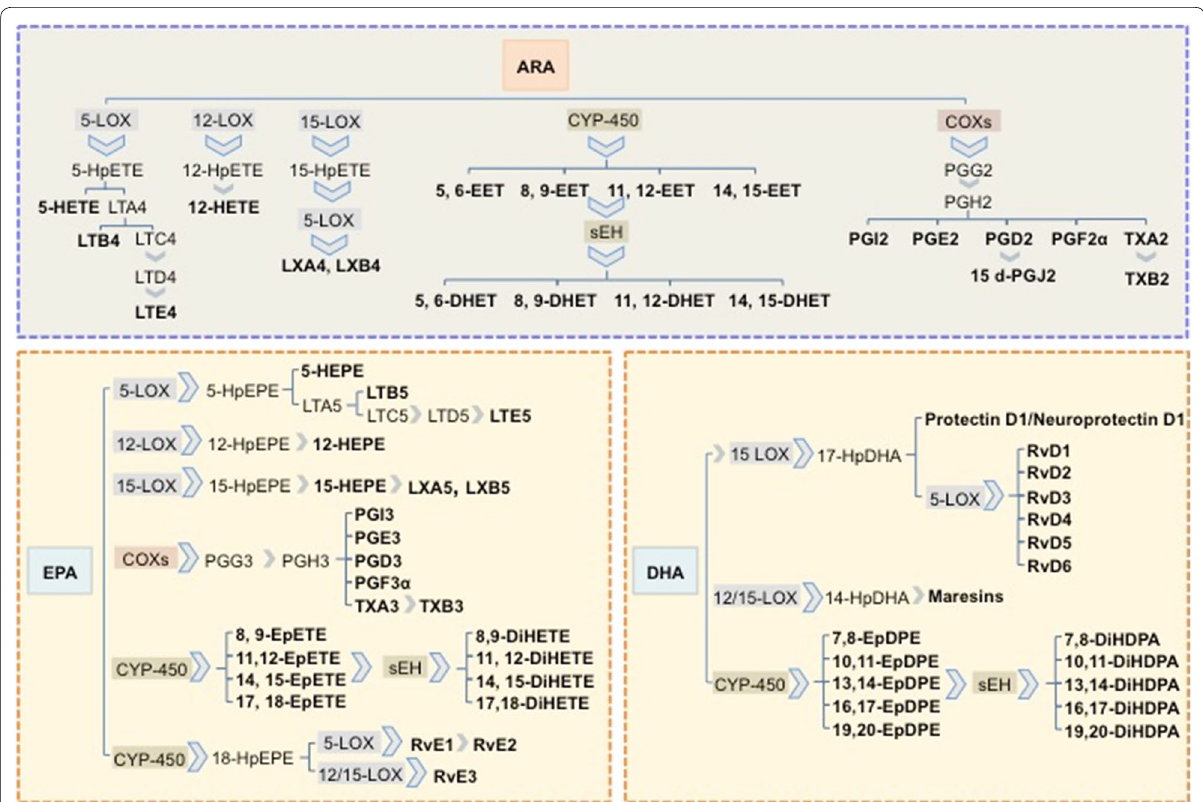
Fig. 2 Principal bioactive lipid mediators derived from ARA, EPA and DHA by the action of lipoxygenases (LOXs), cyclooxygenases (COXs), cytochrome P450 (CYP‑450) and soluble epoxide hydrolase (sEH). ARA (arachidonic acid), DHA (docosahexaenoic acid), DHET (dihydroxy‑ eicosatrienoic acid), DiHDPA (dihydroxy‑docosapentaenoic acid), DiHETE (dihydroxy‑eicosatetraenoic acid), EET (epoxy‑eicosatrienoic acid), EPA (eicosapentaenoic acid), EpDPE (epoxy‑docosapentaenoic acid), EpETE (epoxy‑eicosatetraenoic acid), HEPE (hydroxy‑eicosapentaenoic acid), HETE (hydroxy‑eicosatetraenoic acid), HpDHA (hydroperoxy‑docosahexaenoic acid), HpEPE (hydroperoxy‑eicosapentaenoic acid), HpETE (hydroperoxy‑ eicosatetraenoic acid), LT (leukotriene), LX (lipoxin), PG (prostaglandin), Rv (resolvins), TX